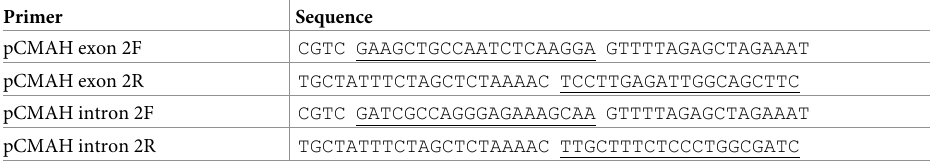
Table 1. Primer pairs used to construct sgRNA expression